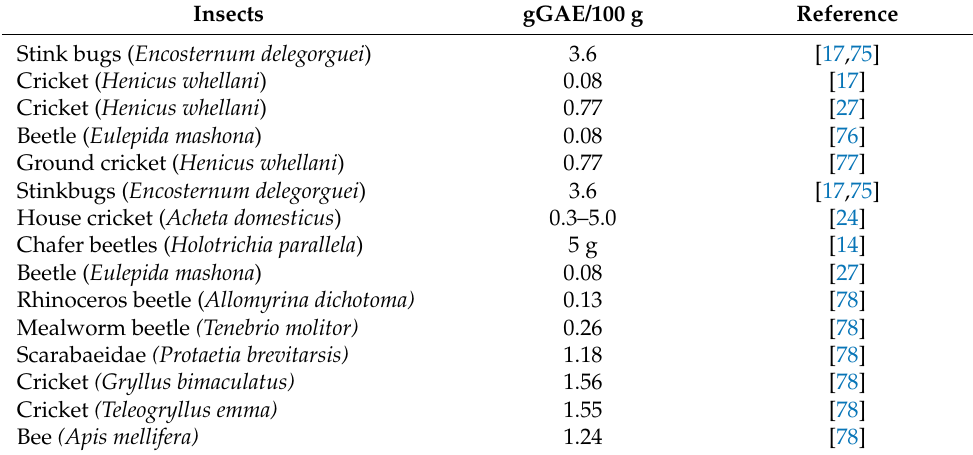
Table 2. Total Polyphenol Index (TPI) expressed as gGAE/100 g (GAE, Gallic acid equivalent).